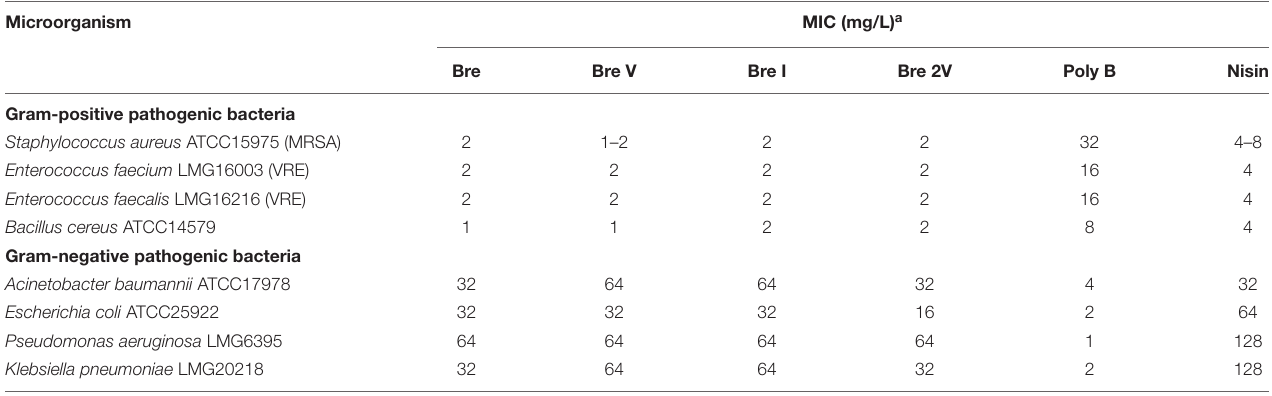
TABLE 1 | Minimum inhibitory concentration (MIC) values of brevibacillins against pathogenic bacteria. Microorganism MIC (mg/L) a Bre Bre